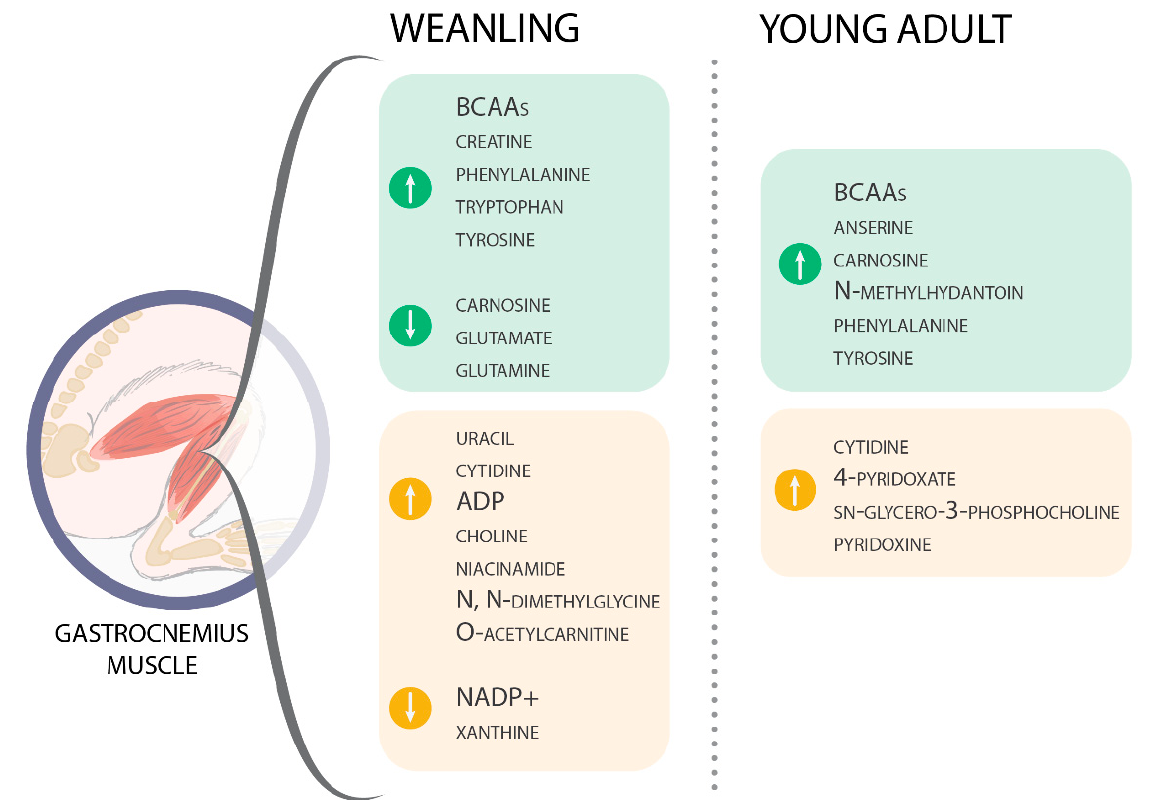
Figure 5. Main metabolic alterations identified in the gastrocnemius muscle in weanling and young adult Walker-256 tumour-bearing rats during cachexia evolution, leading to impacted metabolic pathways more related to an expressive catabolic process and diverted energy production in muscle tissue. In addition, the results showed the distinct impact of cancer cachexia regarding the host’s age.